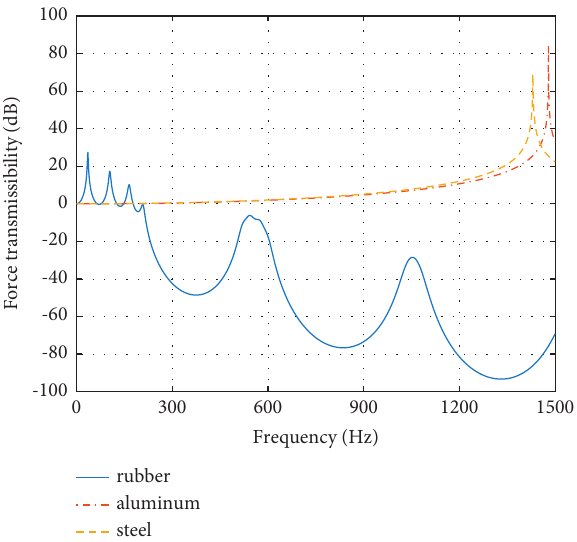
Figure 21: Force transmissibility of PSPS with different passive materials under hybrid